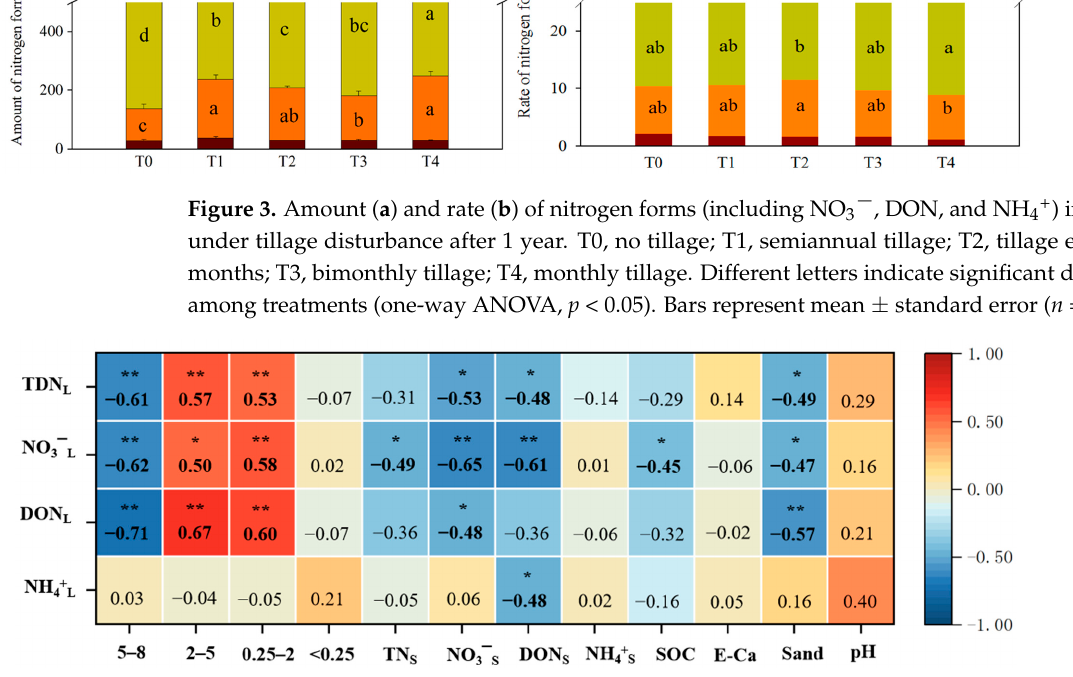
Figure 4. Correlation analysis of N leaching and soil physicochemical properties. The asterisk (*) and (**) represent that the correlation is significant ( p < 0.05 and p < 0.01, respectively). TN S , NO 3 ¯ S , DON S , and NH 4+ represent total nitrogen, nitrate, dissolved organic nitrogen, and ammonium in the soil after one-year simulation experiment. TDN L , NO 3 ¯ L , DON L , and NH 4+L represent the accumula- tive amounts of total nitrogen, nitrate, dissolved organic nitrogen, and ammonium in leaching water during the one-year experiment. E-Ca represents exchangeable calcium in soil.